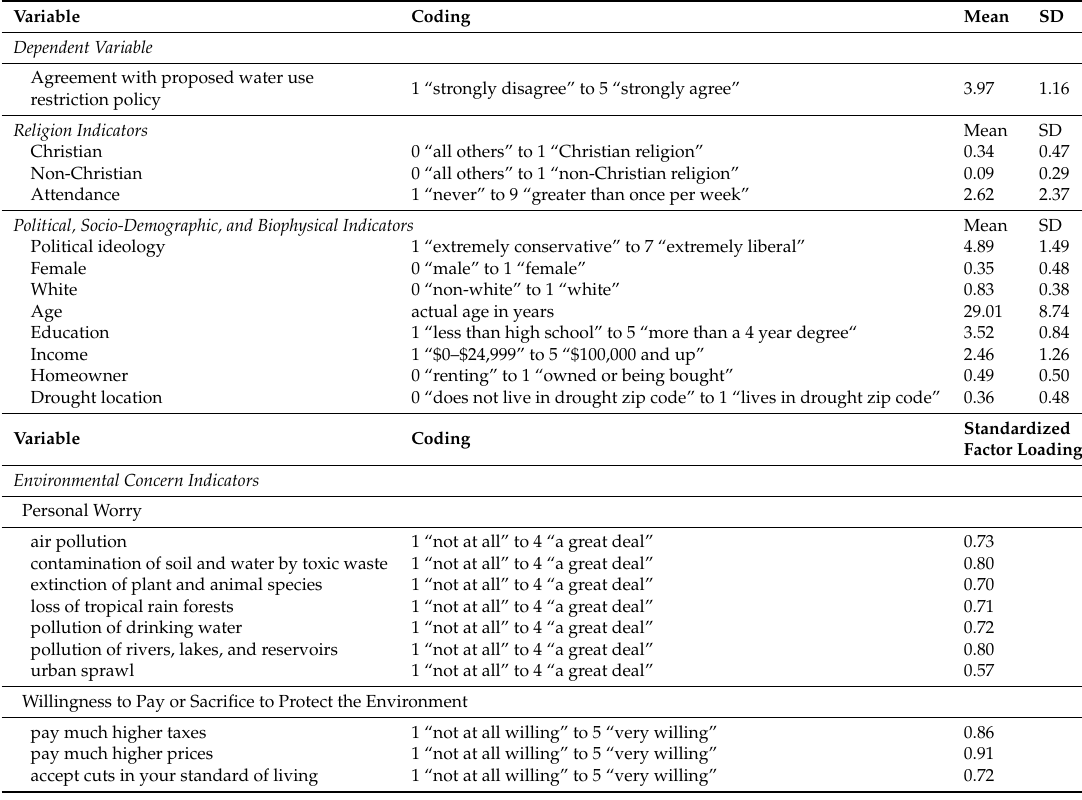
Table 1. Description, coding, mean, and standard deviation of the variables used in the study. Variable